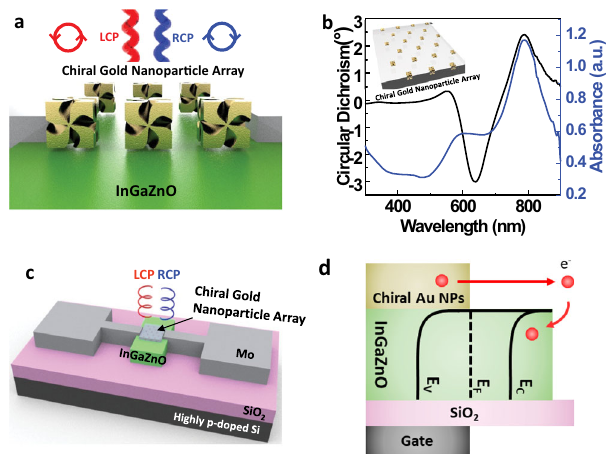
Fig.1|SchematicofthechiralgoldnanoparticlesandCPL-detectingtransistor. a Schematic of the chiral gold nanoparticle array used as a medium to distinguish LCP light and RCP light. b Circulardichroism and extinctiondata ofthe chiralgold nanoparticle array. c Schematic of the CPL detector consisting of a chiral gold nanoparticlearrayintegratedwithanInGaZnOtransistorthatactsasahotelectron acceptor. d Corresponding energy band diagram of the CPL-detecting